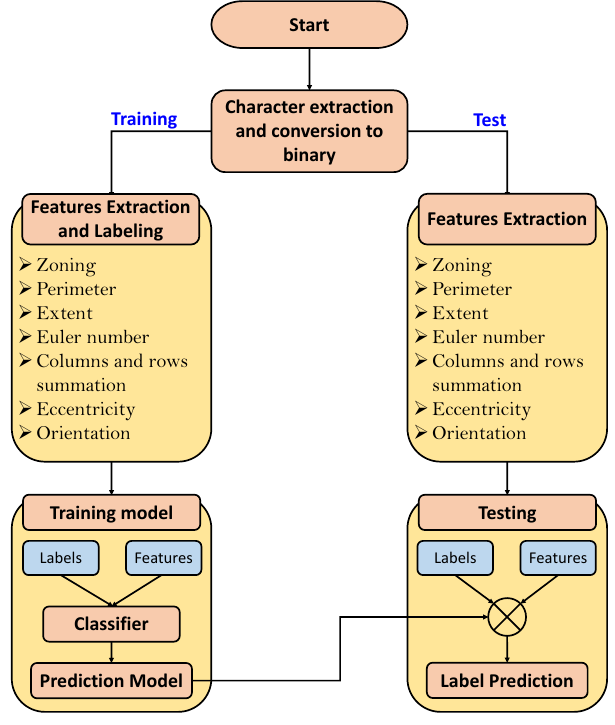
Figure 7. An overview of LP characters recognition